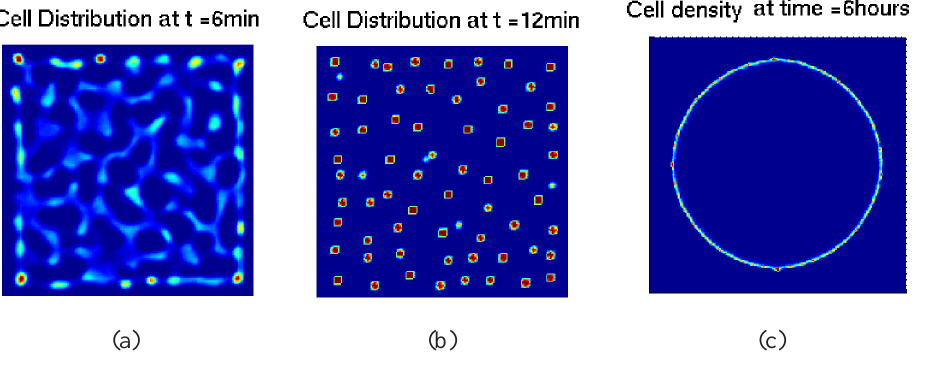
Figure 8. Simulated E. coli patterns by a cell-based model. ( a ) Network formation from an uniform cell lawn; ( b ) Aggregate formation from the network; ( c ) Traveling wave formation from a single inoculum in the center. Adapted from [187] with